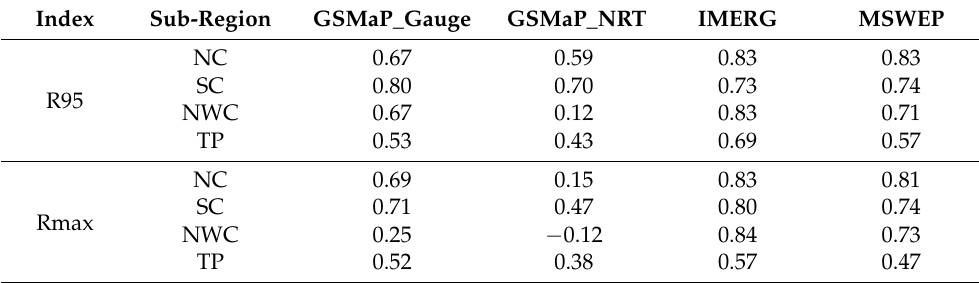
Table 5. The global BMI of extreme indices in four